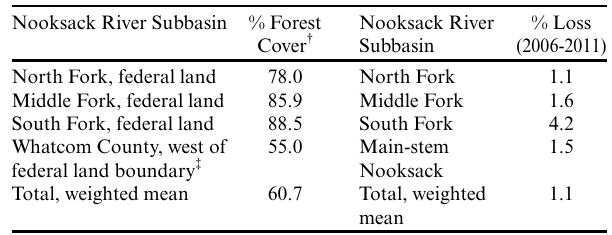
Table 3 . Forest cover and loss in the Nooksack River basin. The left columns distinguish between forest on federal (U.S.